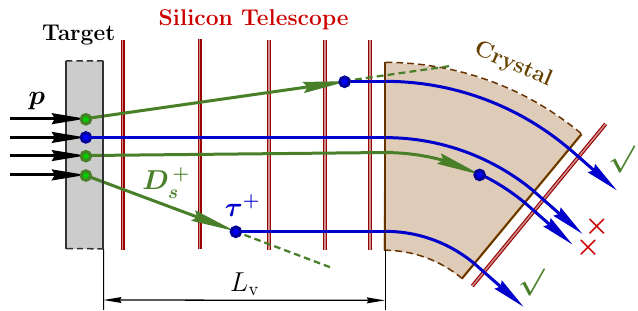
Figure 3 . Schematics of the setup with a silicon telescope